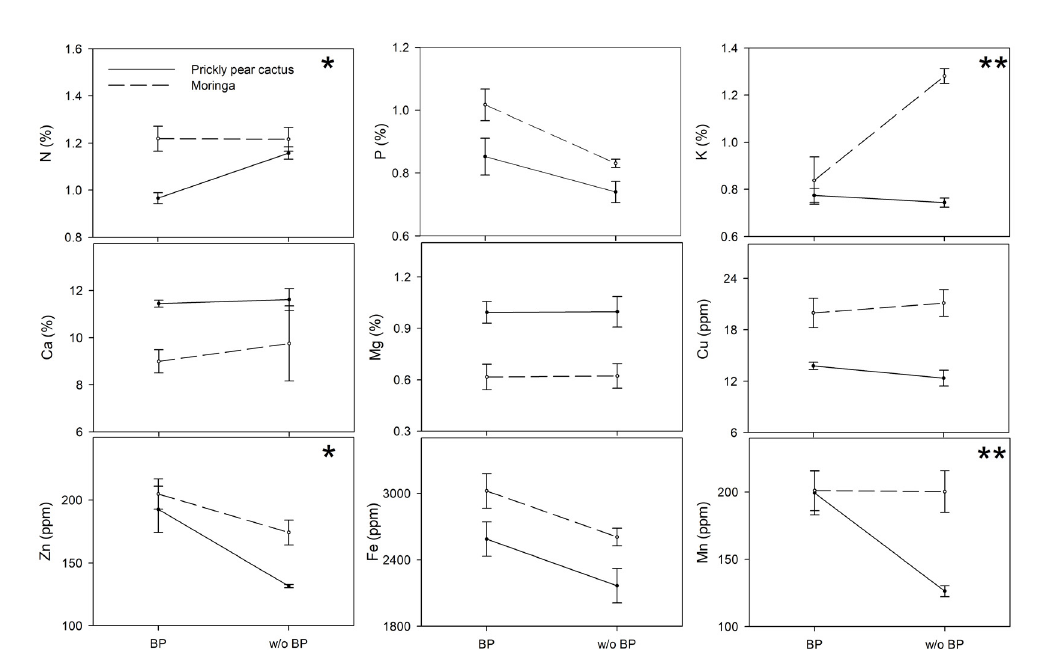
Figure 5: Compost macro- and microelements after 100 days composting and its significant (*p<0.05) and highly significant (**p<0.01) inter- action between evaluated factors (BP: Biopreparations and compost substrate). Means (±SD) were calculated from five replicates for each treatment and sampling day